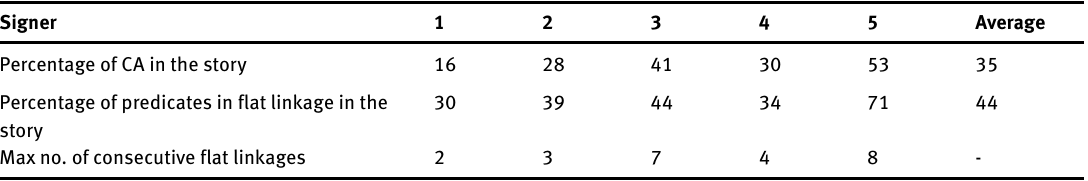
Table 7. Percentage of CA and predicates employed in flat clausal linkage in the story and maximum number of consecutive flat linkages in the